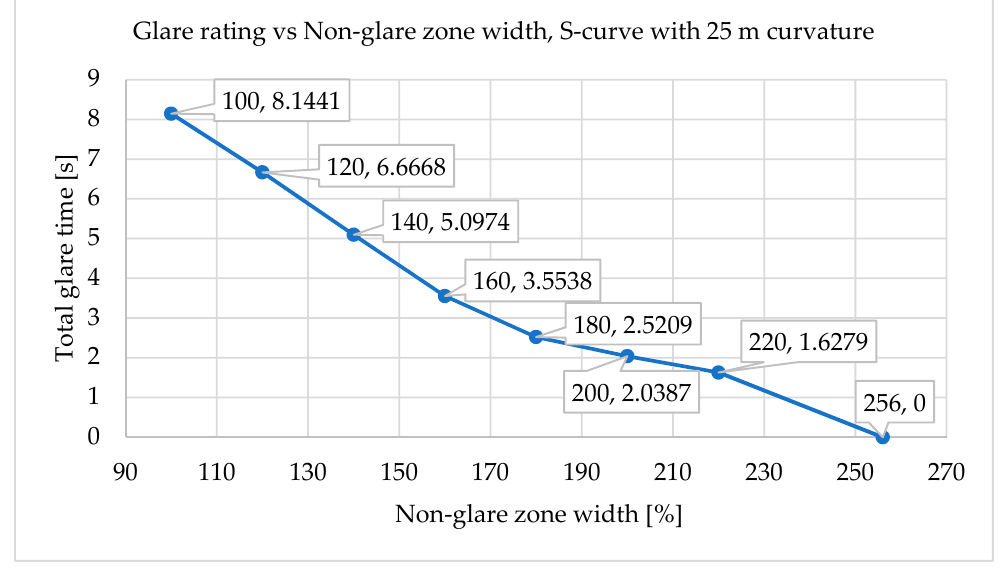
Figure 11. Total glare time vs. non-glare zone width for S-curve with 25 m curvature, showing that the total glare time reduces with increasing non-glare zone width. All glare is eliminated if the non-glare zone widens to 256% of the boundary box width.